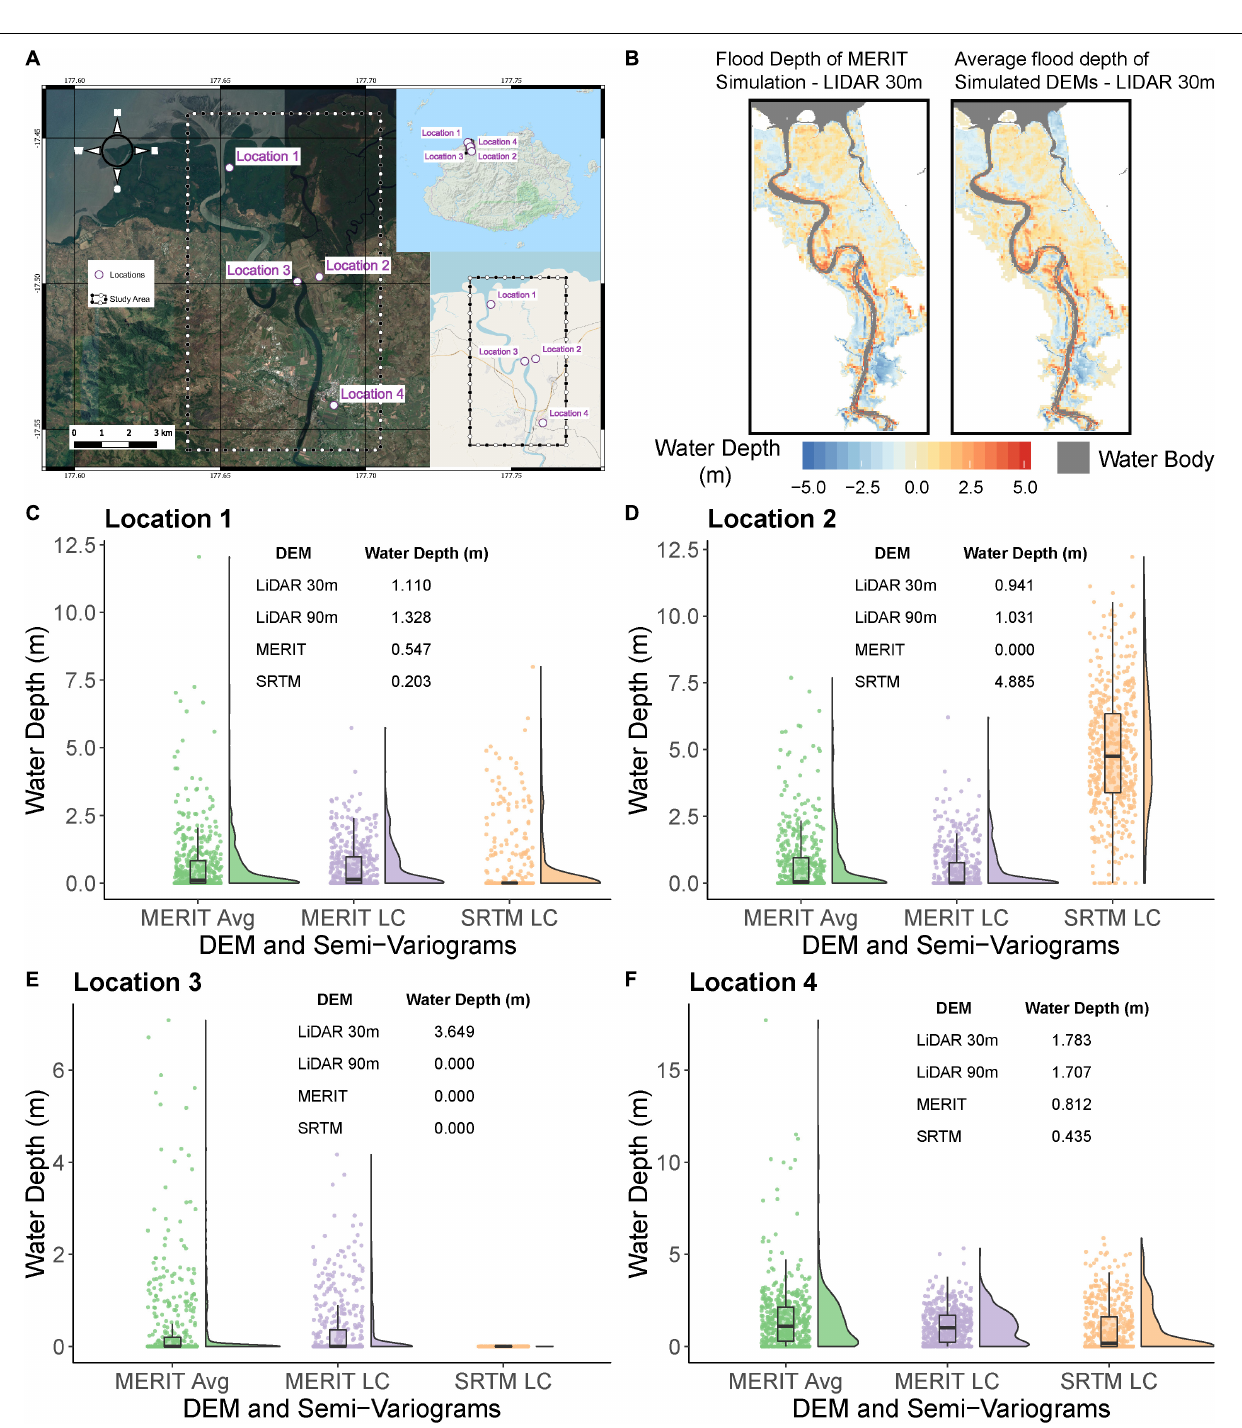
Frontiers in Earth Science |